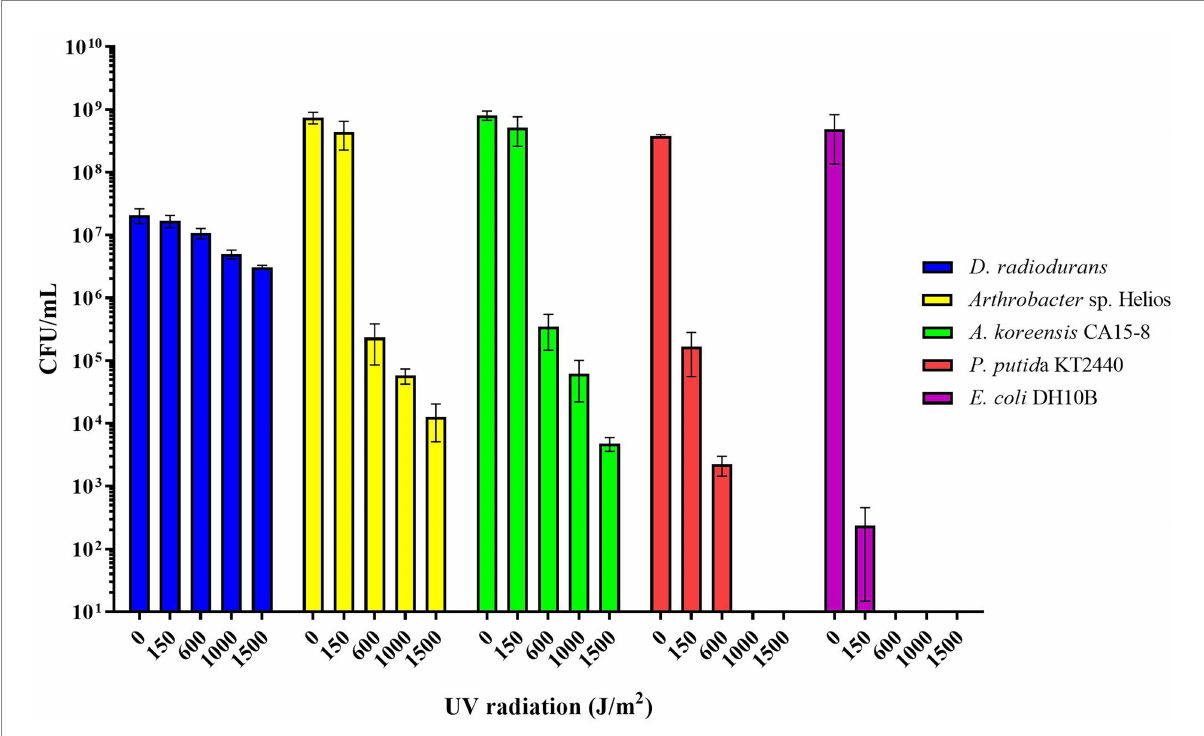
FIGURE 4 Comparison of the resistance to UV irradiation of Arthrobacter sp. Helios, A. koreensis CA15-8, D. radiodurans , P. putida KT2440 and E. coli DH10B cells in stationary phase grown in LB